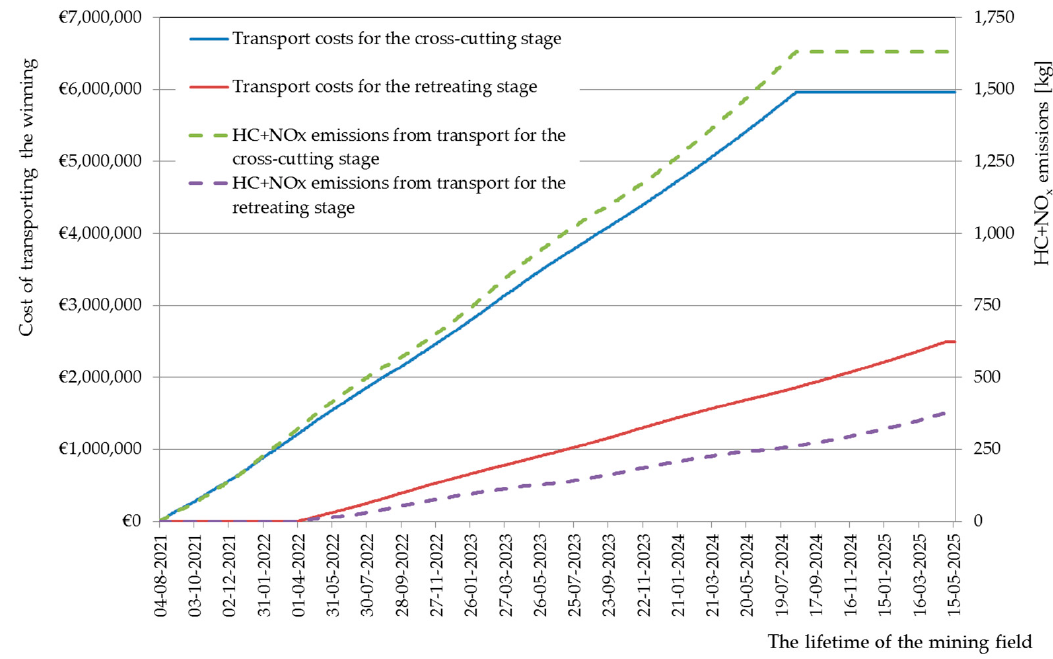
Figure 8. The cost of transporting the excavated material with wheeled haulage during the exploitation of the mining field in a room and pillar mining system (means of transport, complying with the Stage IV standard, selected according to the minimum cost).